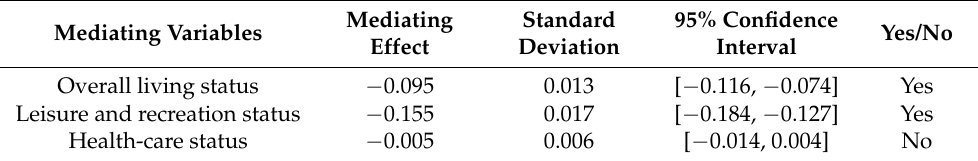
Table 7. Estimated results of mediating